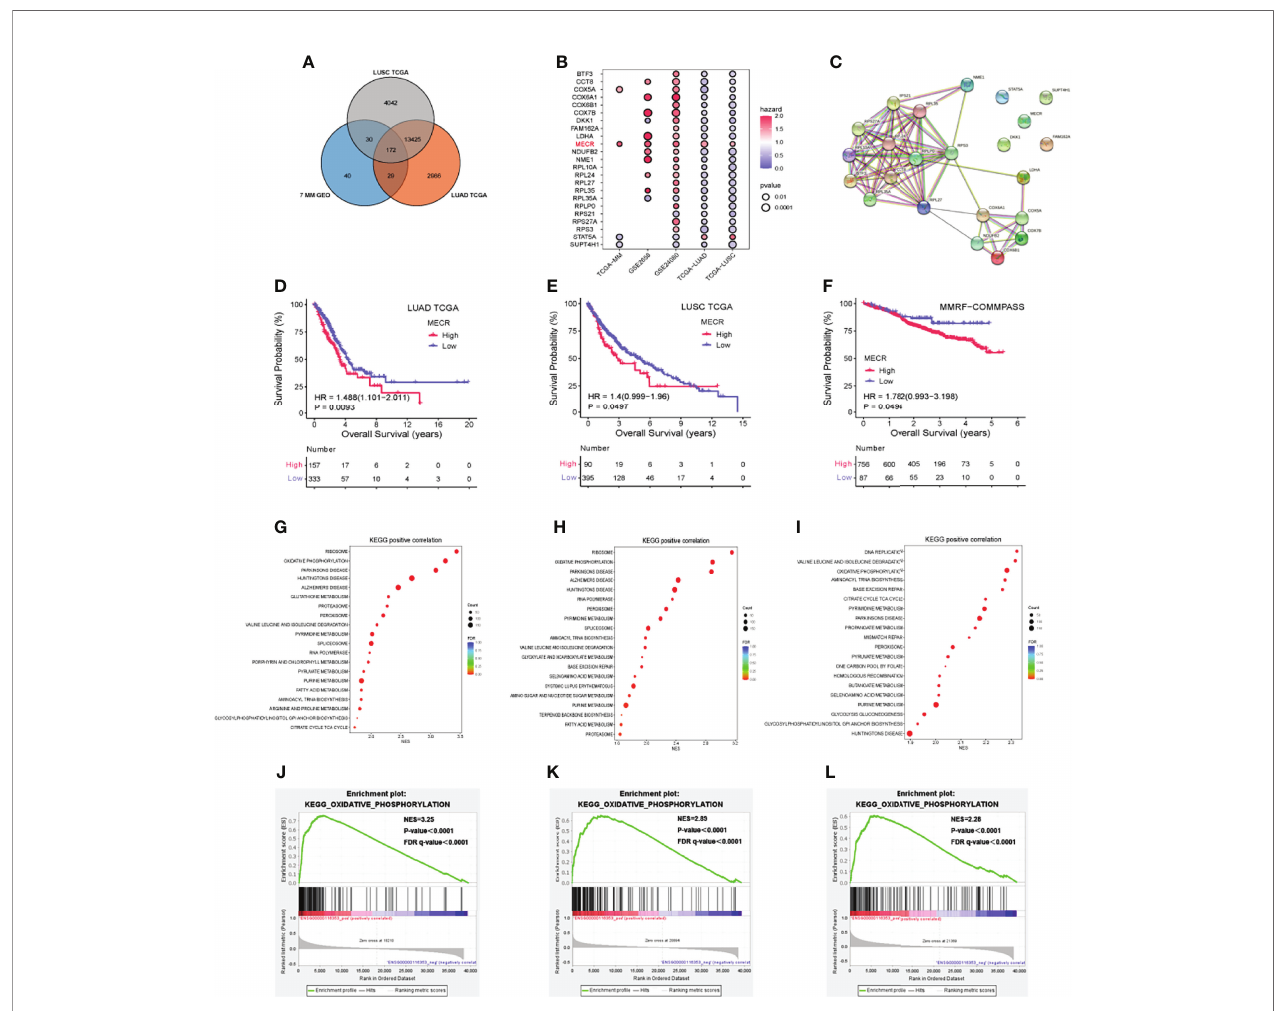
FIGURE 3 | MM and lung cancer bioinformatics analysis (A) Venn diagram indicating the number of differentially expressed genes (B) Correlation of differentially expressed genes with patient over survival (C) Protein-protein interaction network (D – F) Overall survival (OS) analysis based on MECR expression (G – I) Kyoto encyclopedia of genes and genomes (KEGG) pathway enrichment analysis (J – L) High expression of MECR positive correlated with oxidative phosphorylation